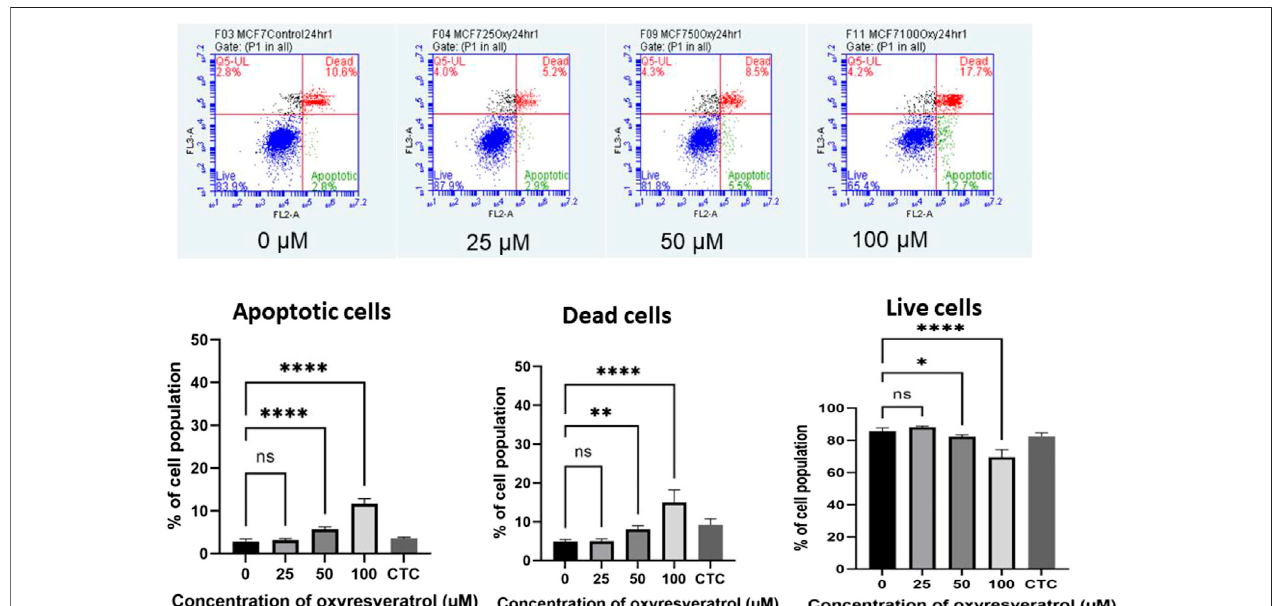
FIGURE 6 | Induction of apoptosis by OXY in MCF-7 cells determined using fl ow cytometry. Bar graphs showing the percentage of MCF-7 cells in apoptosis, live cells and dead cells when treated with 0, 25, 50 and 100 μ M OXY for 24 h and camptothecin (CTC) for 4 h and then subject to fl ow cytometric analysis. Data are the mean ± SEMofthreeindependentexperiments.StatisticalanalysiswascarriedoutusingOne-wayANOVAanalysisofvariancefollowedbyDunnett ’ stest.Thesigni fi cant difference was compared relatively to control (* p (cid:2) 0.037, ** p (cid:2) 0.003 and **** p < 0.0001).